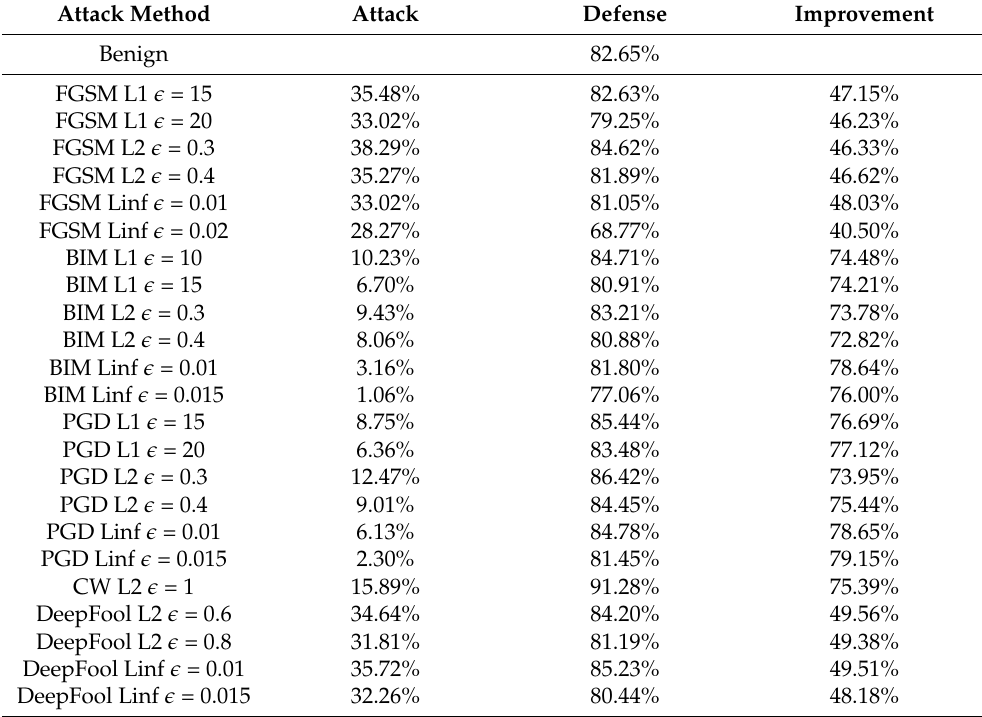
Table 4. Defense against adversarial attacks by MAD on VGG16 and CIFAR-10 dataset.